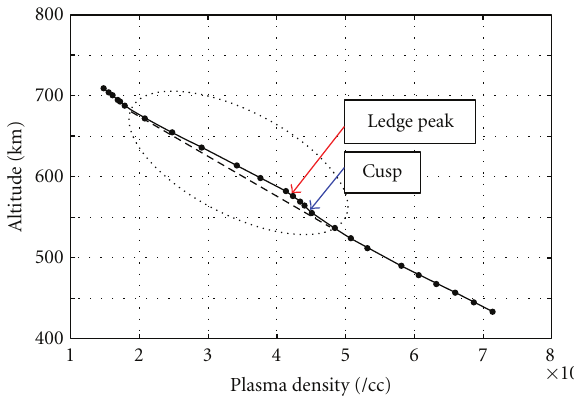
Figure 12: The N ( h ) profile reduced from the ionogram obtained on-board the Ohzora (EXOS-C) satellite at 284.2 ◦ E long., 0.5 ◦ N dip lat. At 12.0 LT in March 17, 1987 (from Uemoto et al. [49]). Vertical and horizontal axis indicate the altitude and the plasma density, respectively. The red arrow gives the peak of the ledge structure. The blue arrow indicates and the height corresponding to the